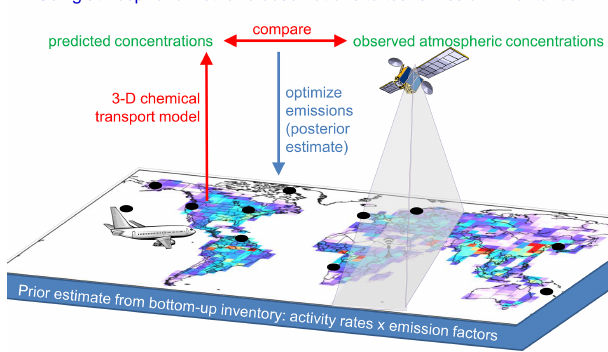
Figure 1. Schematic describing how observed atmospheric con- centration data are used with a global chemistry transport model to quantify methane